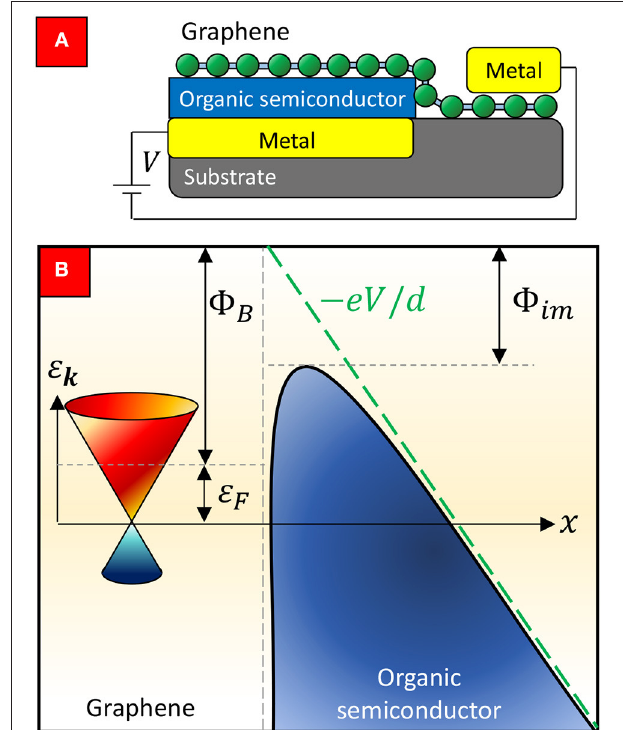
FIGURE 1 | Concept of thermionic carrier injection in graphene/organic Schottky interface. (A) Schematic drawing of a graphene/organic Schottky contact; (B) Energy band diagram of graphene/organic interface, where e 3 V / 4 πεε 0 d represents the image charge 8 im = q